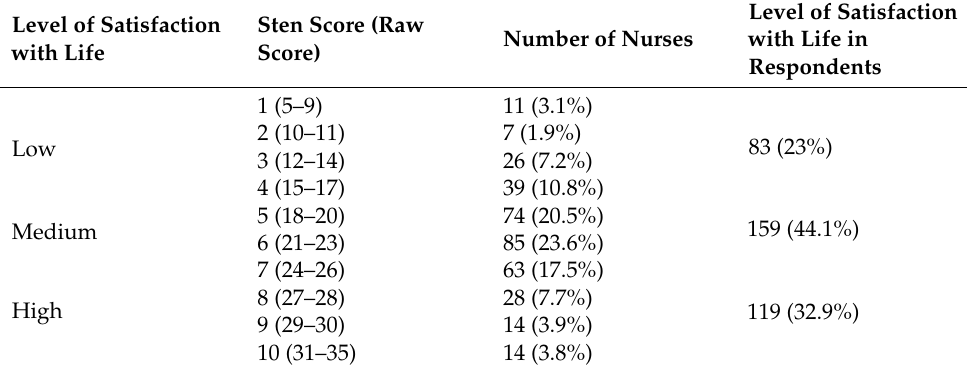
Table 3. Results of the Satisfaction with Life Scale for nurses.